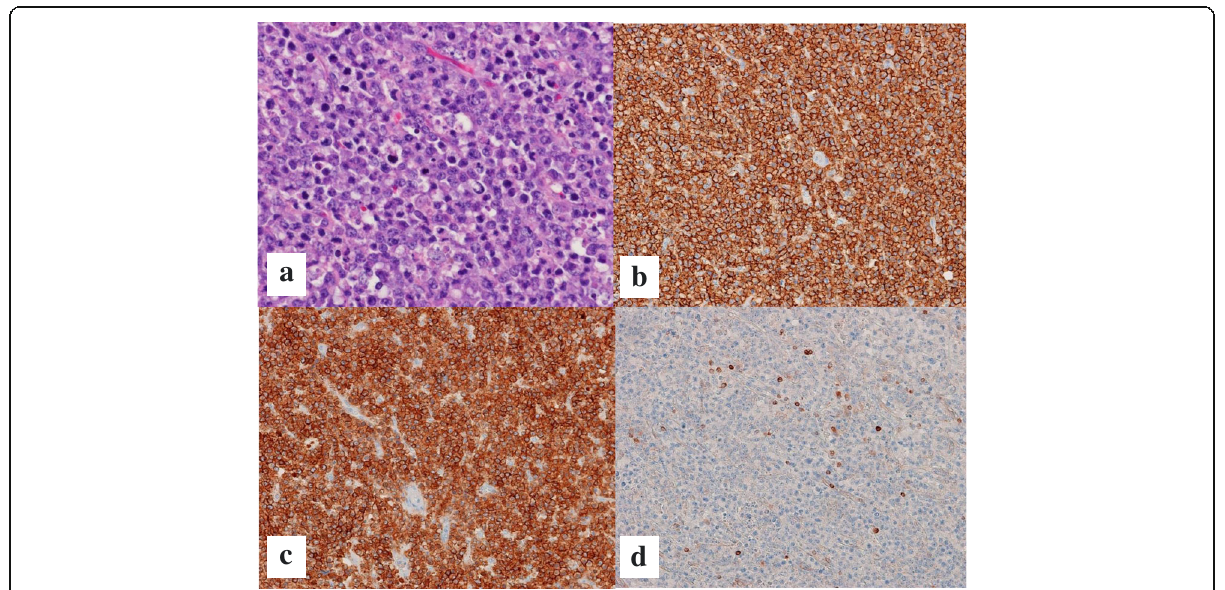
Fig. 4 Hematoxylin and eosin staining (× 200 magnification) demonstrated that viable lesions in the tumor were composed of diffusely